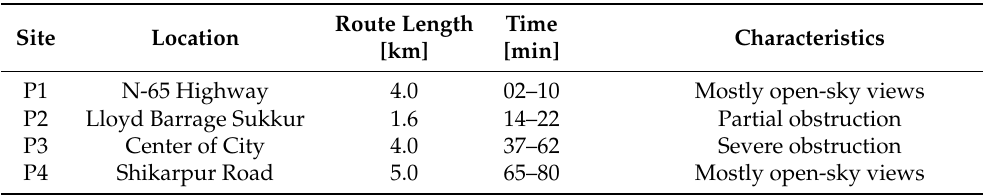
Table 1. The route length, observation time and signal-reception characteristics of the observation windows P1, P2, P3 and P4.